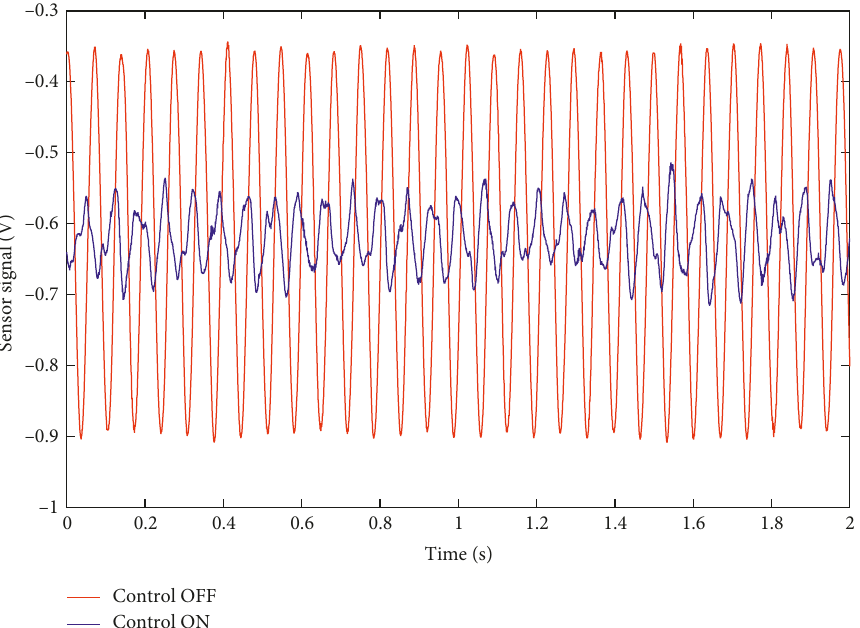
Figure 10: Comparison of time-domain signal with LQR control on/off.